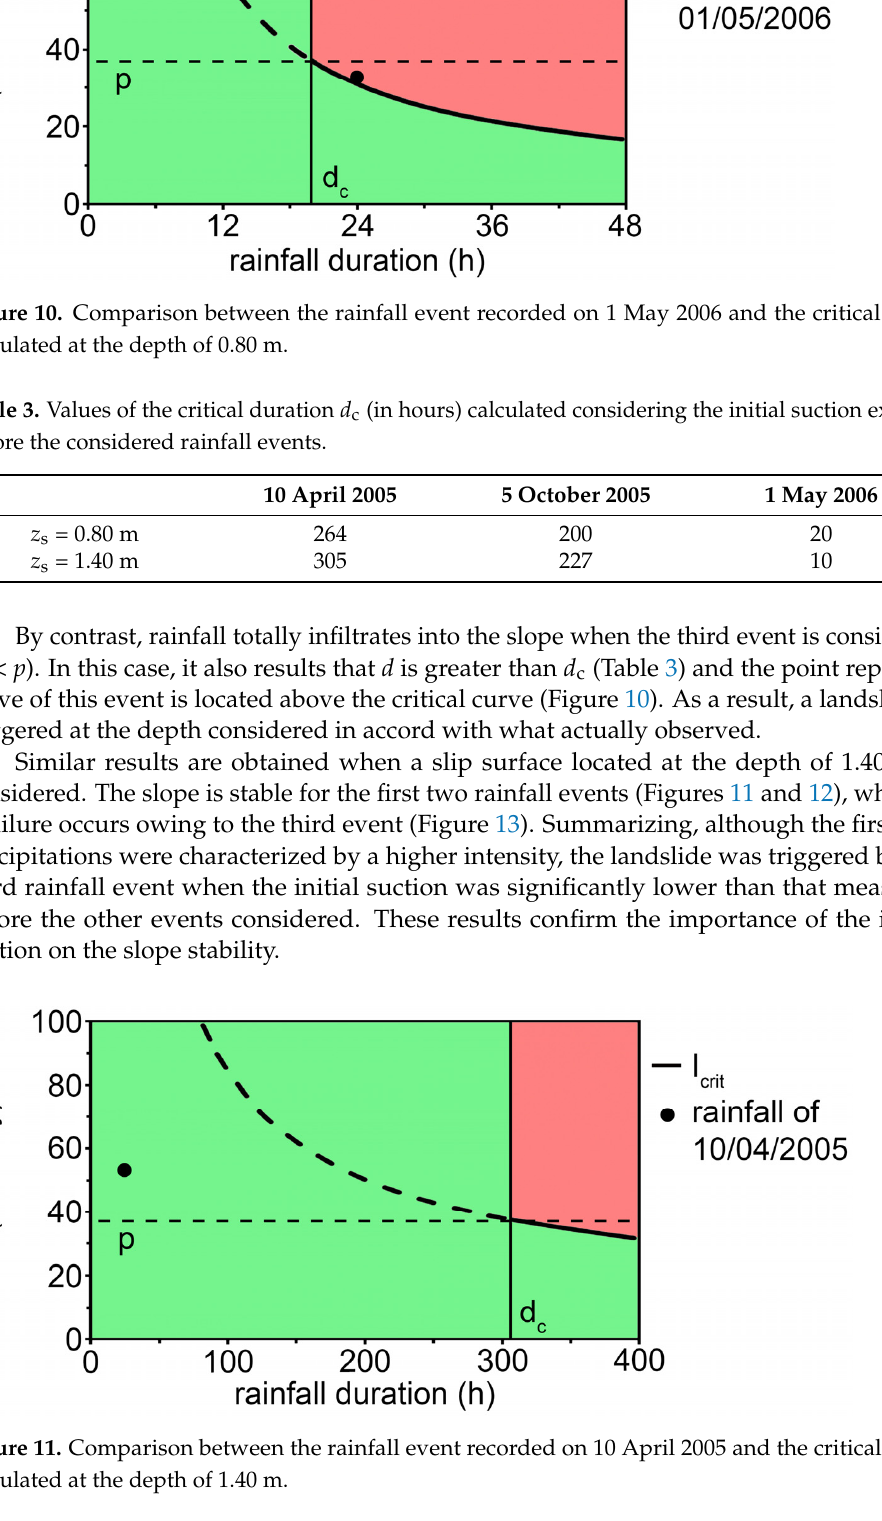
Figure 12. Comparison between the rainfall event recorded on 5 October 2005 and the critical curve calculated at the depth of 1.40 m. Figure 13. Comparison between the rainfall event recorded on 1 May 2006 and the critical curve calculated at the depth of 1.40 m. Finally, for the sake of completeness, Figures 14–16 show a comparison between the evolution of